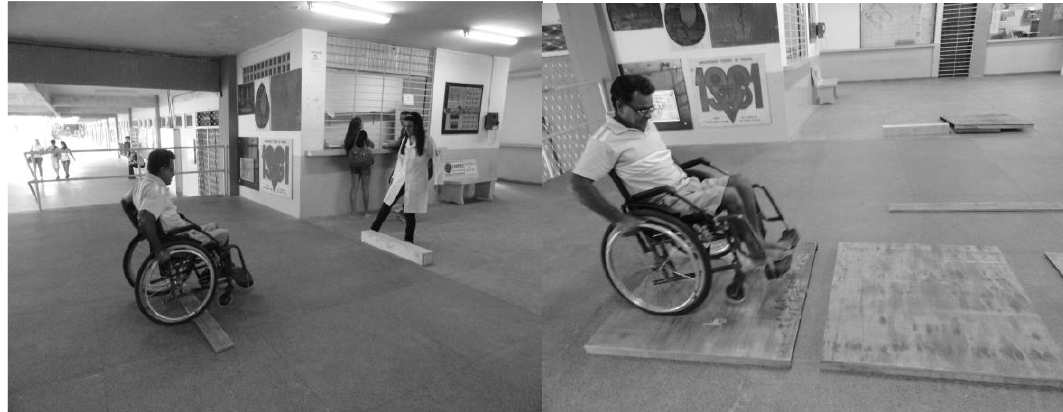
Figura 2. Teste de habilidades em cadeira de rodas (CR) ultrapassando